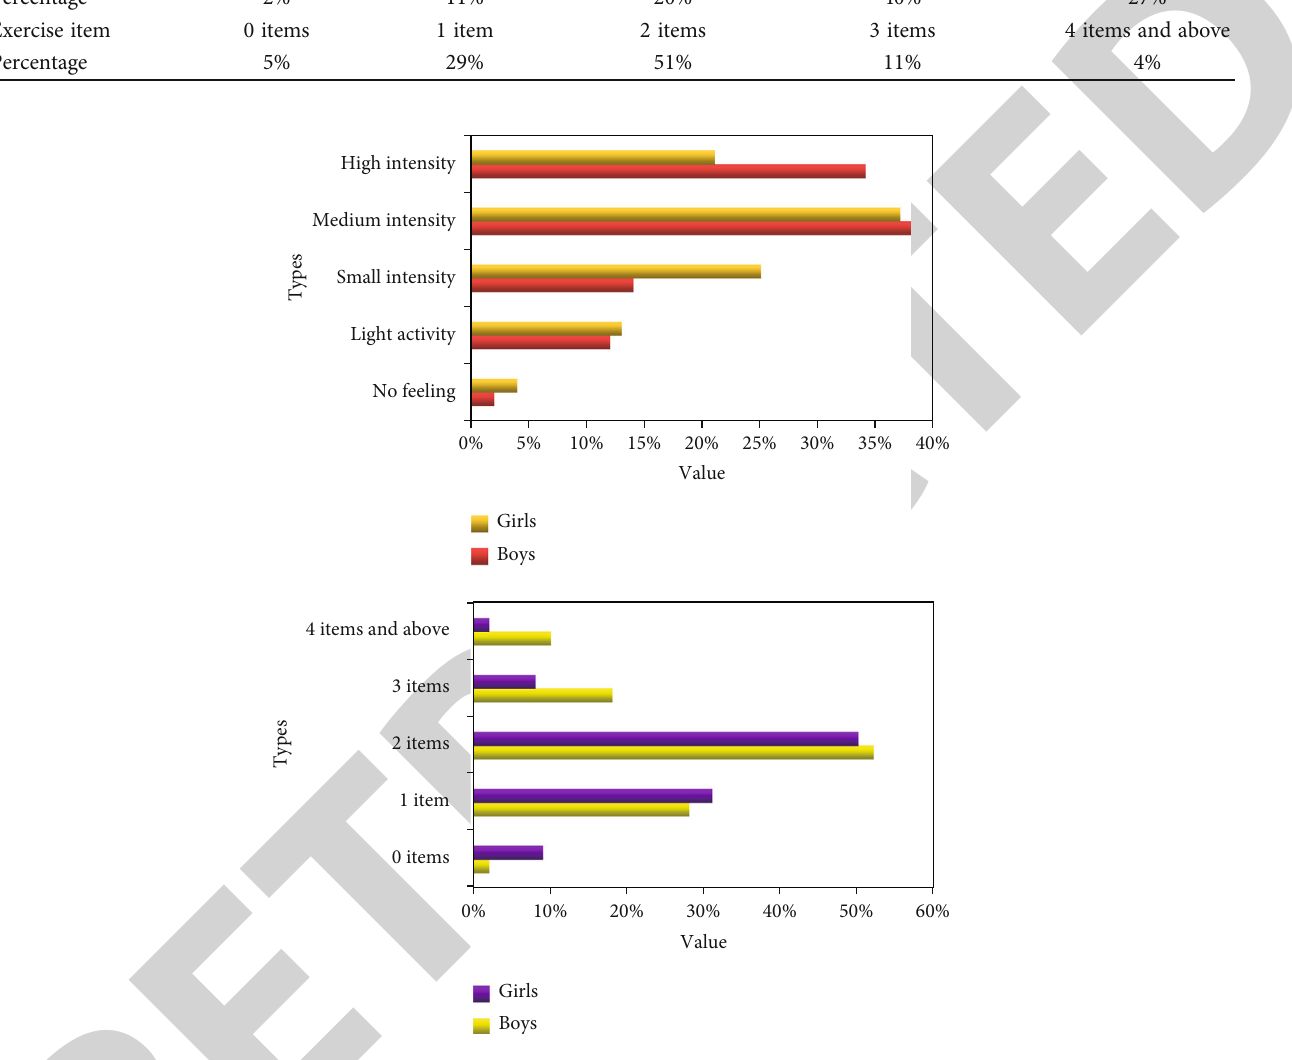
Figure 7: Physical exercise intensity and physical exercise items of students of di ff erent